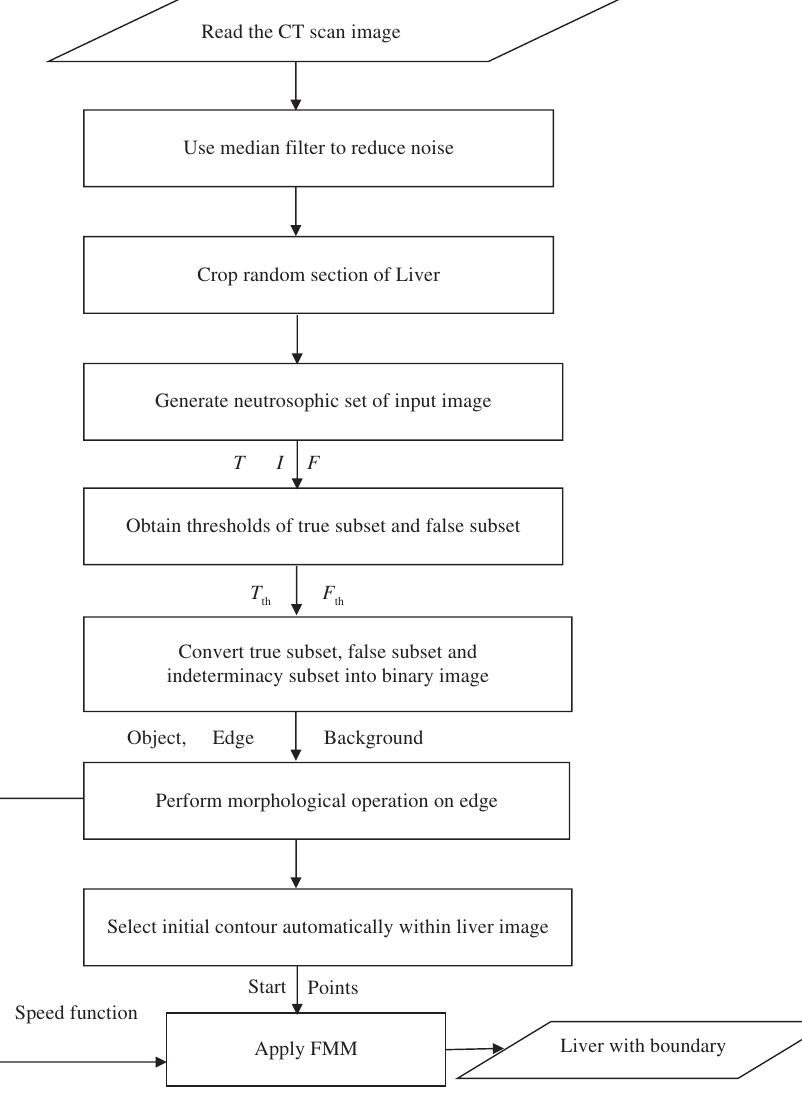
Figure 2: Flowchart of the Proposed Liver Segmentation